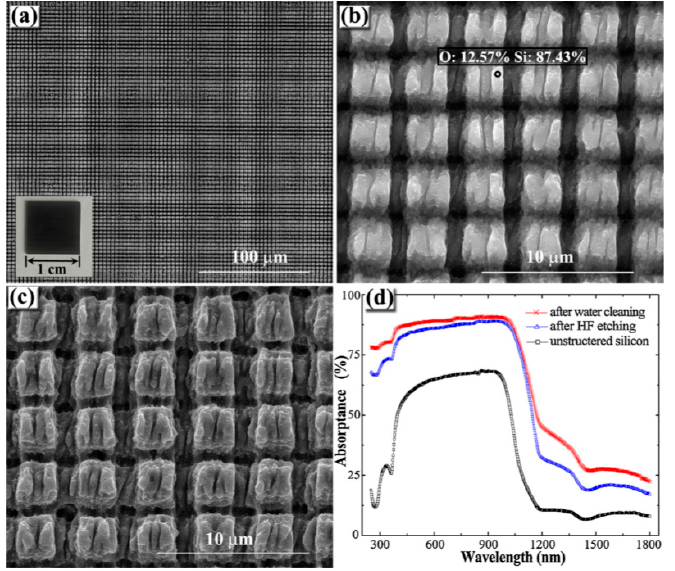
Figure 14. Fabrication of 2D periodic structures on silicon after scanning with fs-laser multi-beams: ( a ) overview of the grid-like structures; ( b , c ) enlarged view of the laser-induced surface morphologies before and after HF-etching for 60 min and ( d ) spectral absorptance of the samples. Reprinted from Pan et al . [99], Copyright 2016, with permission from Elsevier.